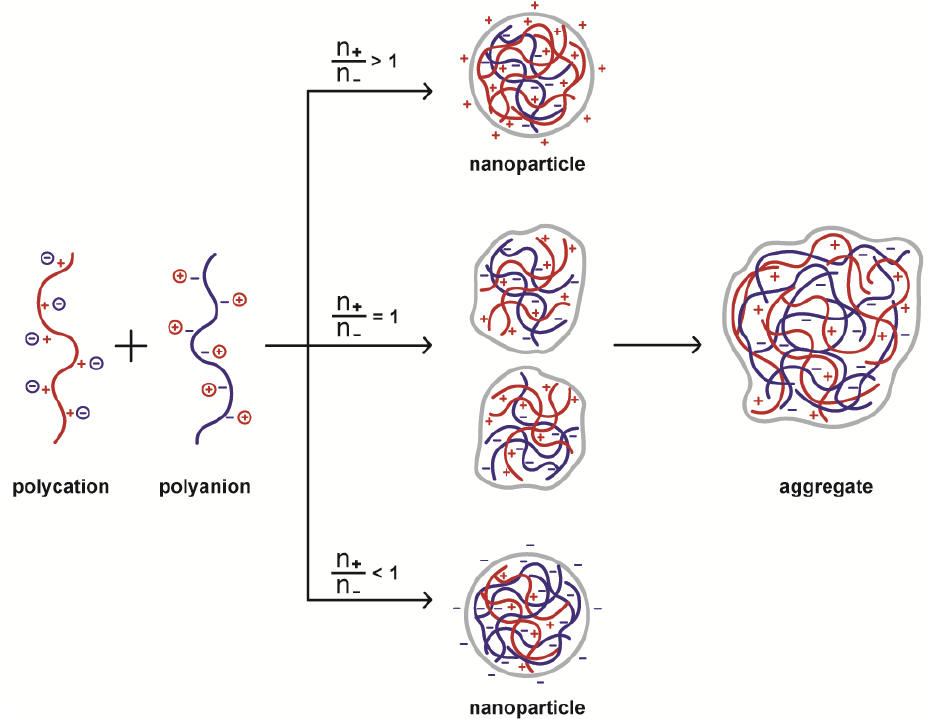
Figure 3. Effect of the polyelectrolytes charge ratio on the size and charge of the polyelectrolyte complexes (PEC) formed. When the charge ratio is different from one, the nanoparticles formed are charged with the same charge as the polyion in excess. If the charge ratio equals one, uncharged particles are formed, thereby producing large aggregates.